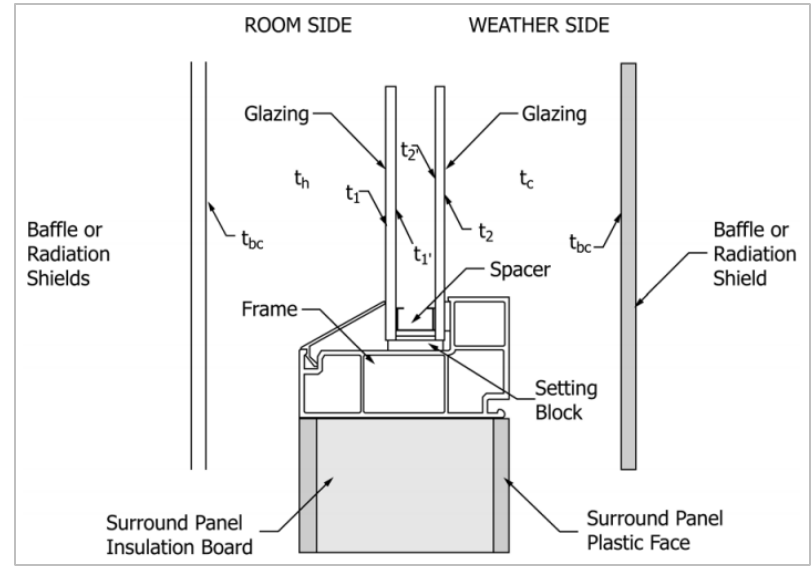
Figure 14. ASTM C1199 testing setup.